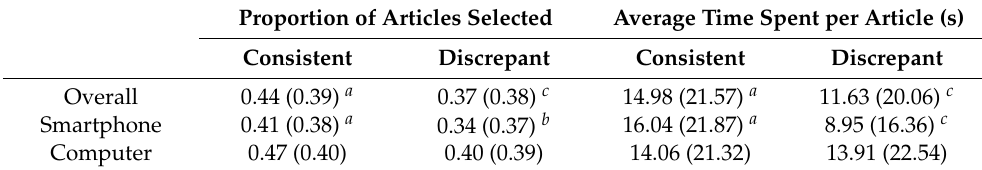
Table 1. Confirmation Bias by Browsing Device Condition (Study 1). Proportion of Articles Selected